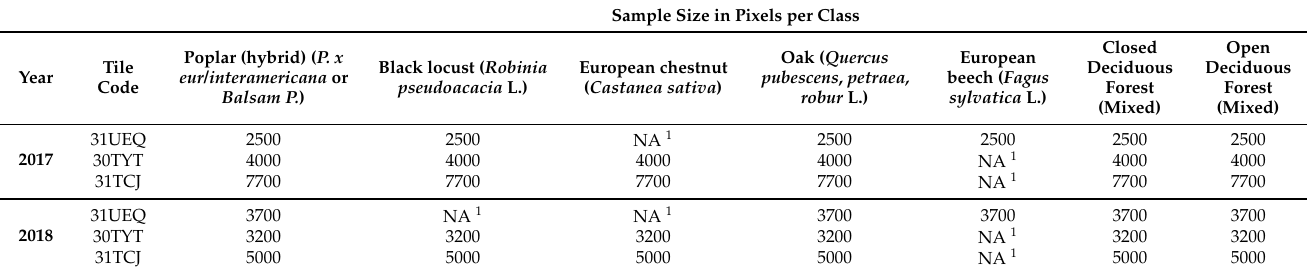
Table 2. Total number of reference samples per class extracted from each S2 tile, after the removal of outliers.